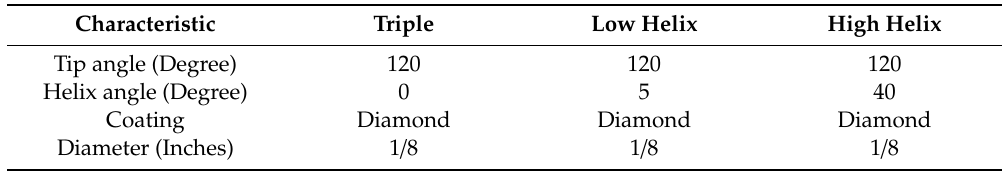
Table 2. Specification of the tool.